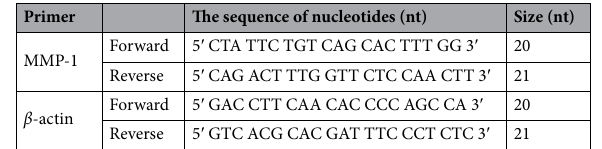
Table 4. The forward and reverse primers used for amplification of Matrix metalloproteinase 1 (MMP-1) and β